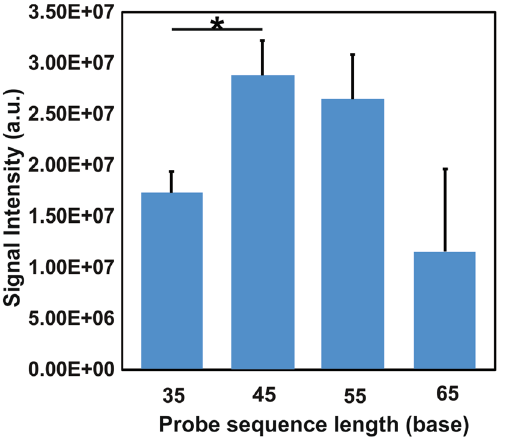
Figure 1. Detection effect comparison based on the length of printed probe sequence. The strongest signal was captured by the 45-base probe. * p ≤ 0.05/comparison times (post hoc test).